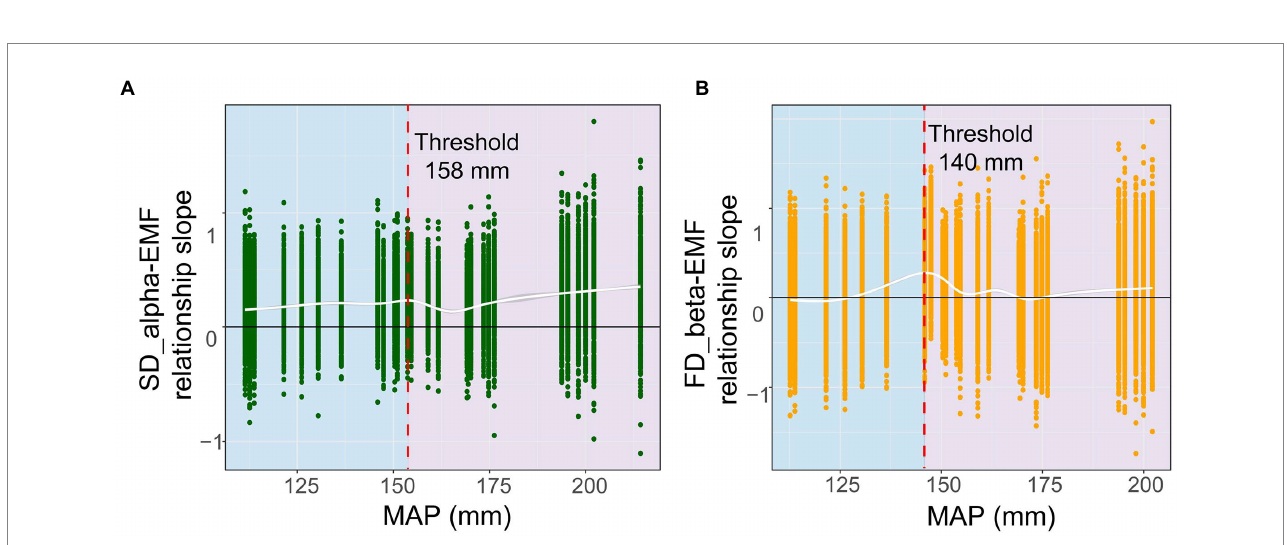
FIGURE 3 Thresholds for shifts in diversity-functionality relationships driven by mean annual precipitation (MAP). (A) alpha diversity; (B) beta